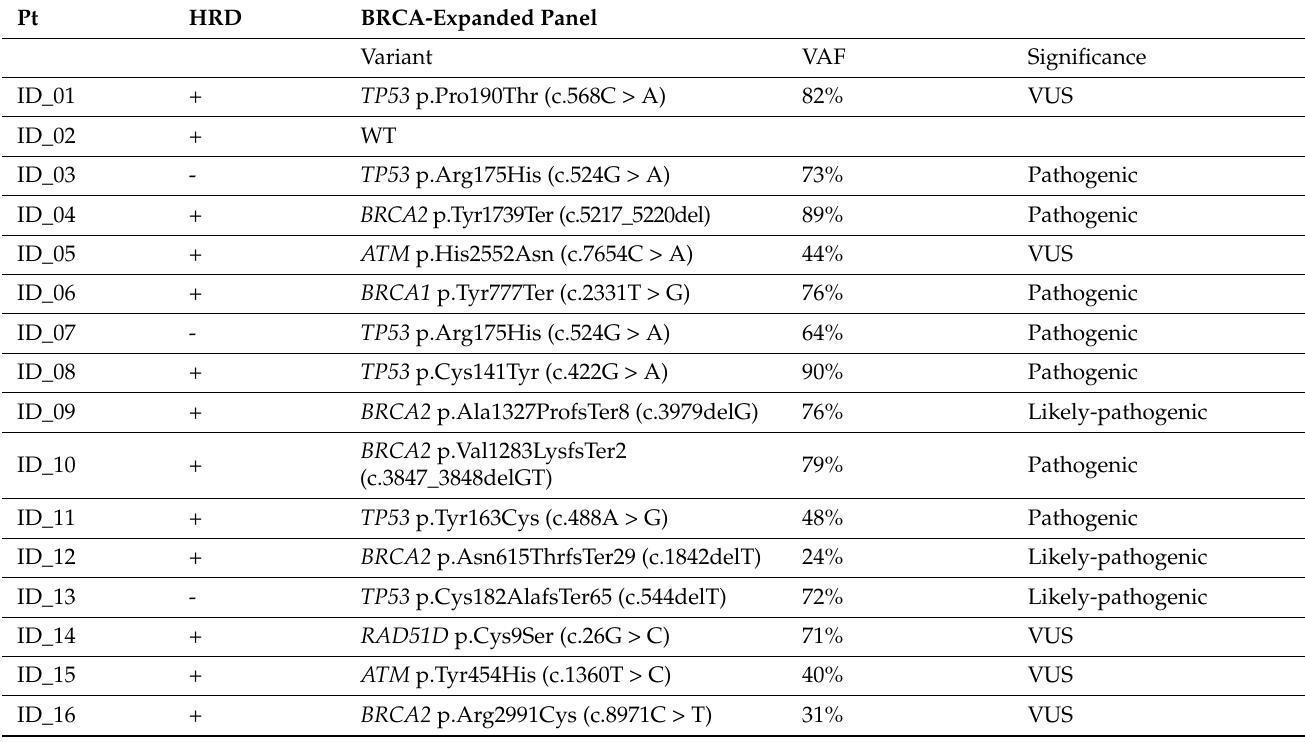
Table 3. Gene variants identified by BRCA-Expanded